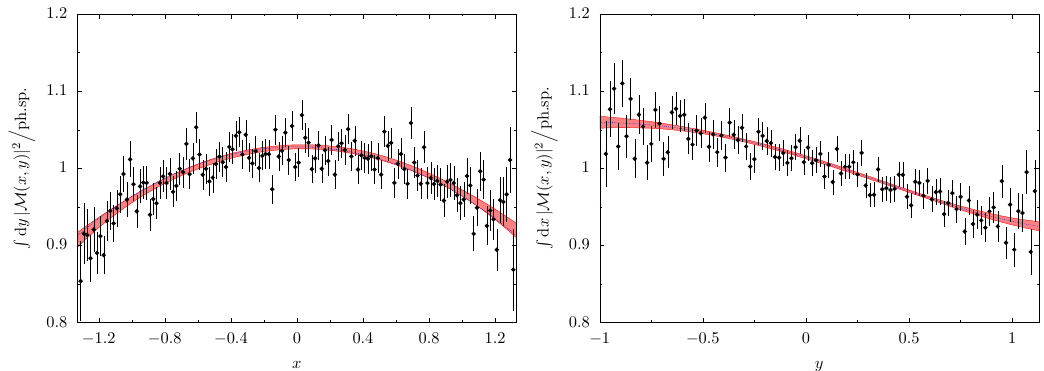
Figure 8 . Dalitz-plot projections in x - and y -direction, which are divided by the corresponding phase space. We show the measurement of ref. [49] overlayed with our dispersive representations covered by the red error bands. Note that the theoretical x -projection on the left is not perfectly symmetric, due to C -violating contributions. In both panels we depict our central solution for the C -conserving part |M C | 2 by the dotted blue line. 0